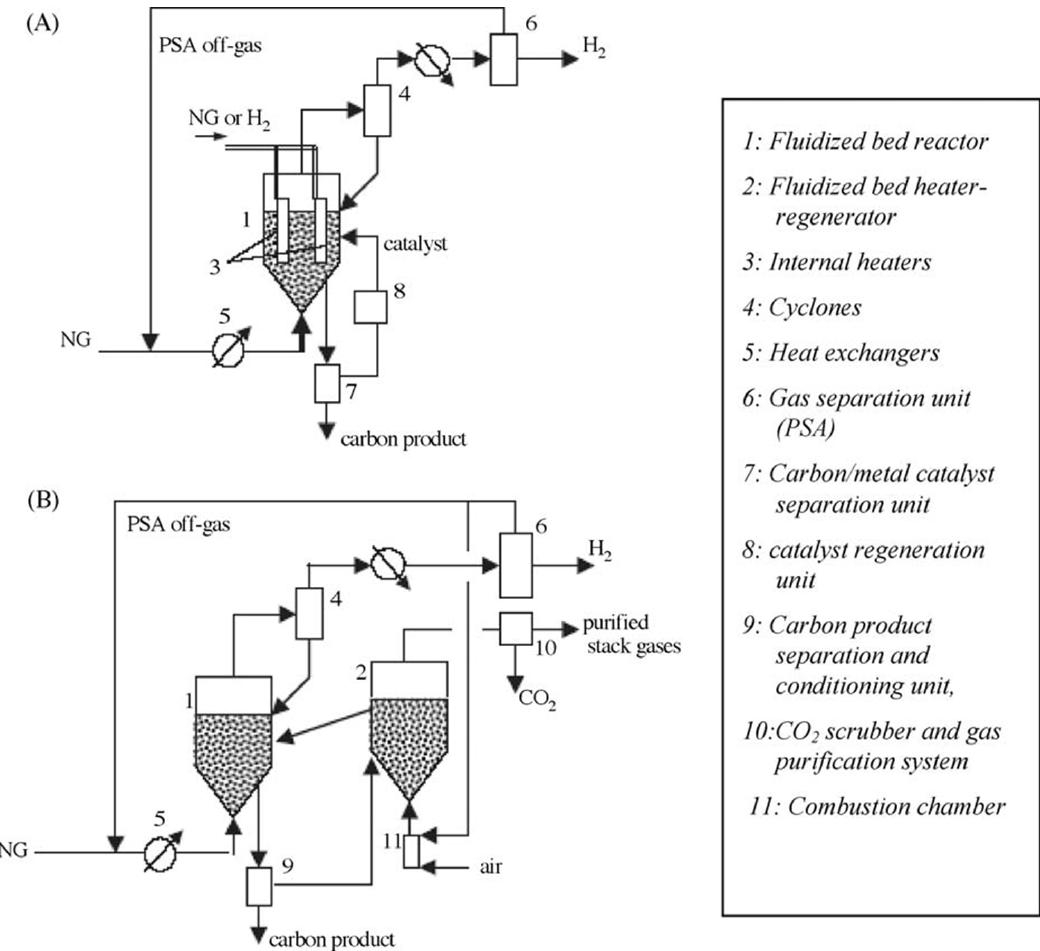
Figure 6. H 2 and carbon are created by catalytic cracking of natural gas using both endothermic reactions ( A ) and exothermic reactions ( B ) (License Number: 5411971299711) [19].